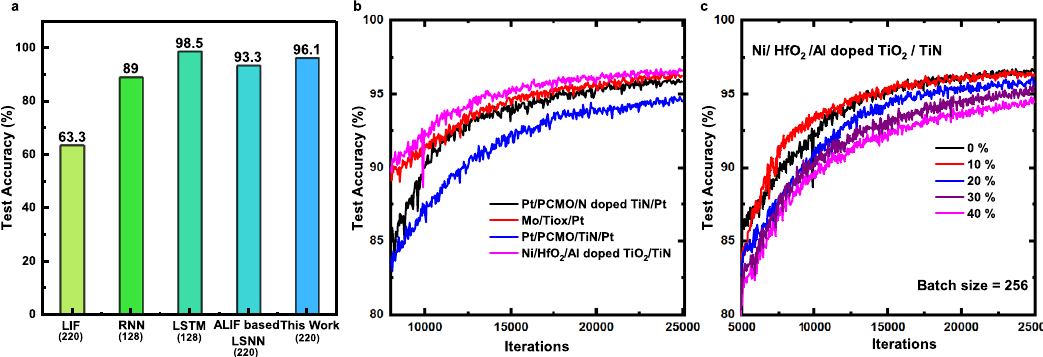
Fig. 8 Benchmarking of DEXAT based LSNN. a Test accuracy comparison for classifying SMNIST using different neuron cells. Numbers in brackets indicate number of cells. b Test accuracy comparison on SMNIST for parameters extracted from different device stacks and full DEXAT experiments on HfO TiO 2 / 2 device. c Test accuracy comparison on SMNIST with different resultant variabilities for